Question: What style of plot is this figure drawn as?
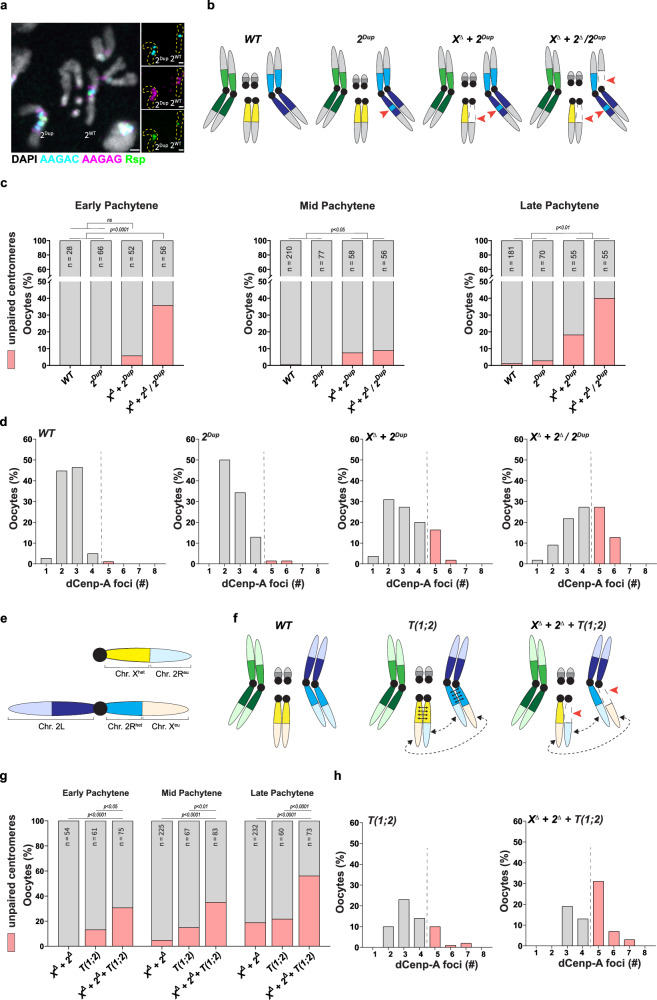
Answer: histogram